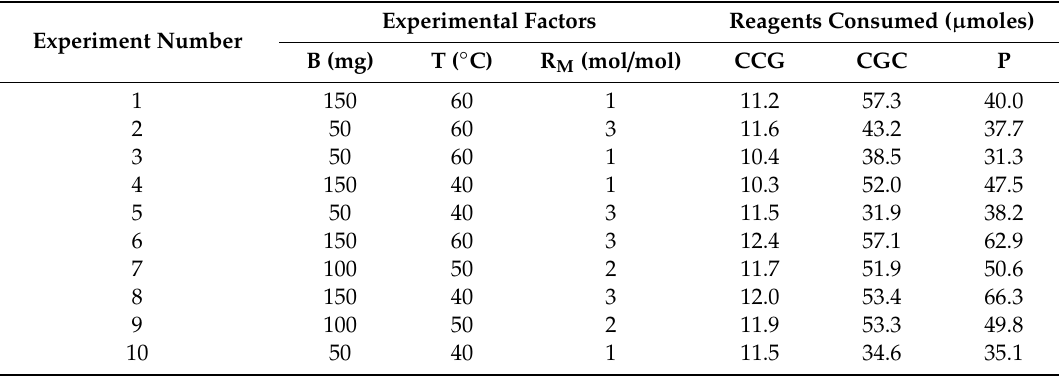
Table 2. Established experimental factors and reagents consumed during enzymatic esterification of dicaprin with palmitic acid catalyzed by BCL / chitosan at 6 h of reaction. Experimental Experiment Number